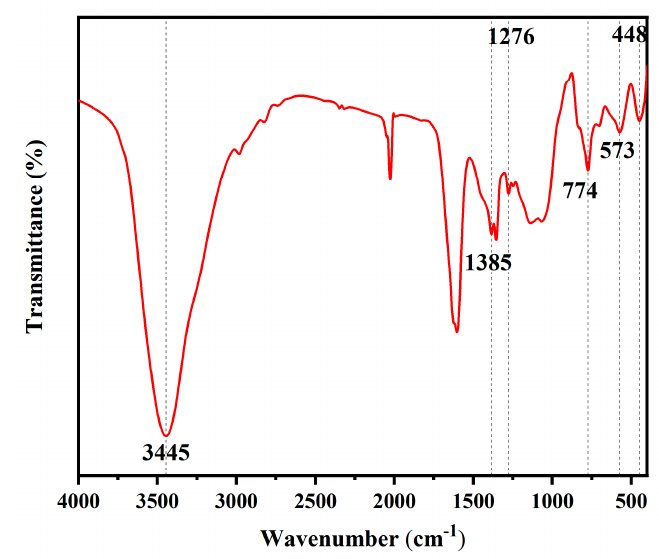
Figure 3. FITR spectra of the PFTS-modified 0.5 g ZrO 2 -SiO 2 sample.